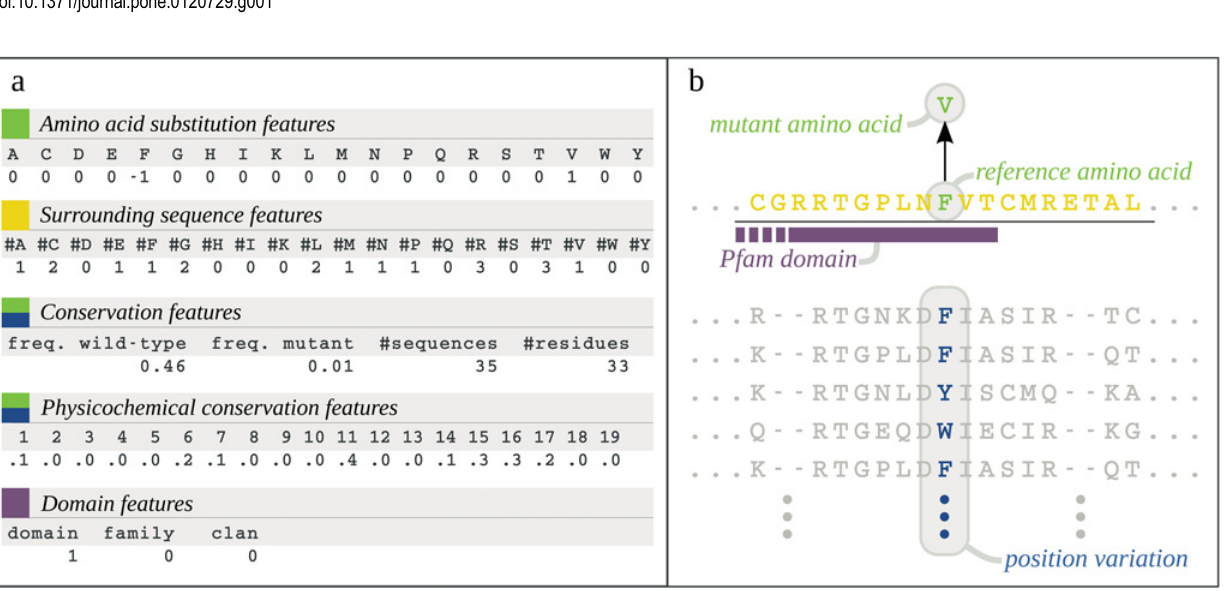
Fig 1. Extracting feature weights from trained classifiers. a) For illustration, objects in two classes (blue and red) are represented by rectangles and characterized by the features “ width ” and “ height ” . b) By measuring widths and heights, objects are mapped to a two dimensional grid (feature space). Classifier training results in the decision boundary that separates the two classes of objects. c) Feature importance can be deducted from the slope of the decision boundary. The height is more important than the width, hence the higher (absolute) weight for this feature. The sign indicates for what class the feature is predictive. Blue rectangles are generally wider, hence the negative weight for the width feature. Red rectangles are generally taller, hence the positive weight for the height feature.